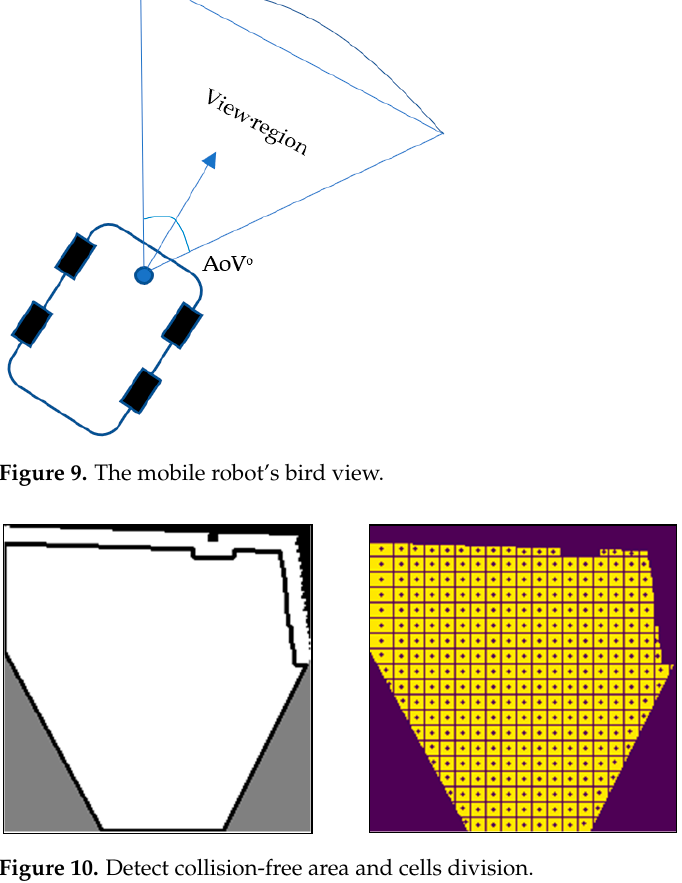
Figure 10. Detect collision-free area and cells division.